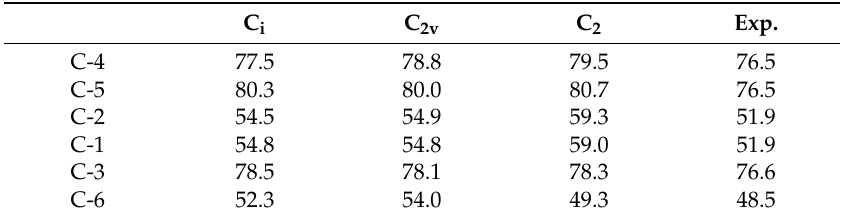
Table 5. Calculated 13 C and 1 H NMR chemical shifts (ppm) values of the symmetrical conformations and experimental values of ETABOC.